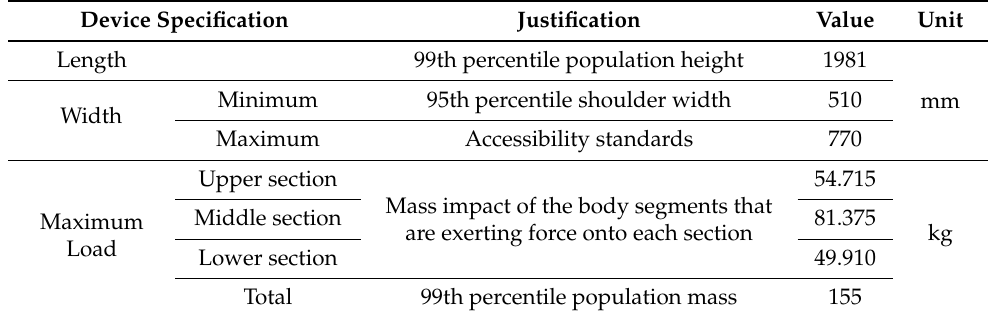
Table 3. Device specifications.